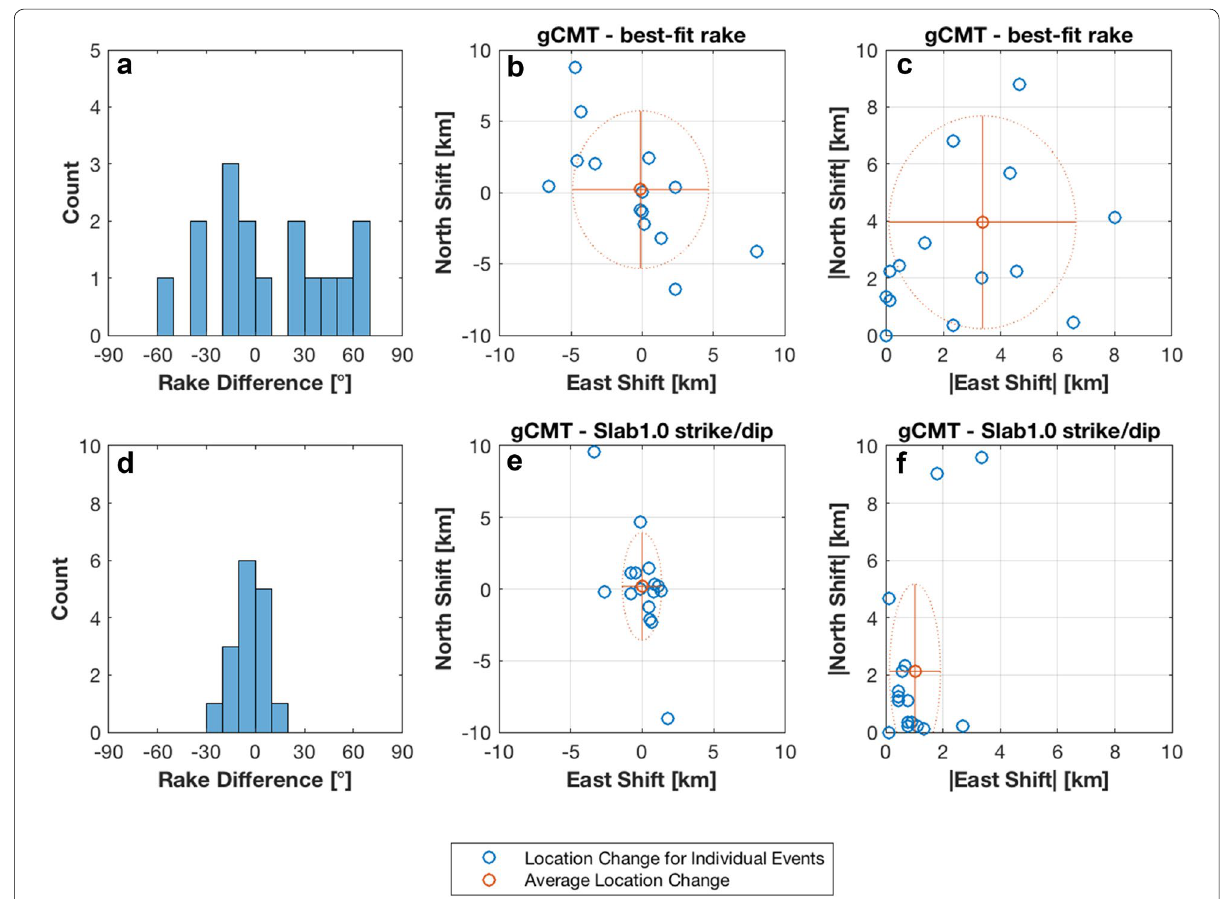
Fig. 3 Sensitivity tests for all modeled megathrust events. Changes in a rake, b location, and c absolute location, when rake is constrained to the initial solution as opposed to the best-fit value. Changes in d rake, e location, and f absolute location, when strike and dip are constrained to the gCMT solutions as opposed to the interpolated Slab1.0